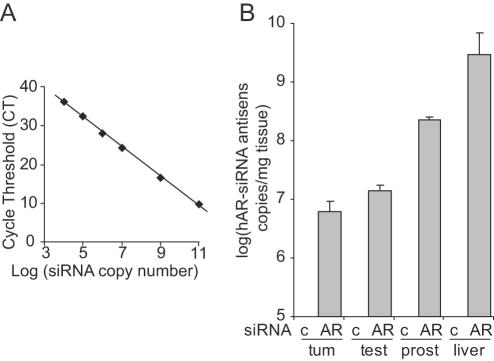
Quantification of siRNA copies in CRCaP tumors and mouse tissues.A: Dynamic range and sensitivity of the hAR-siRNA antisense strand assay. 104 to 1011 copies of the antisense strand of hAR-siRNA were reverse-transcribed using a stem-loop primer. The product was amplified in the presence of SyberGreen and the cycle threshold (CT) plotted against the log of the number of copies of the input target. B: Detection of the antisense strand of hAR-siRNA in tumors (tum), testis (test), prostate (prost) and liver of mice treated with 3 µg of cont- (c) or hAR-siRNA (AR) injected i.p. in 50 µl of saline. The number of siRNA copies is normalized to the tissue weight (mean±SE n = 3).